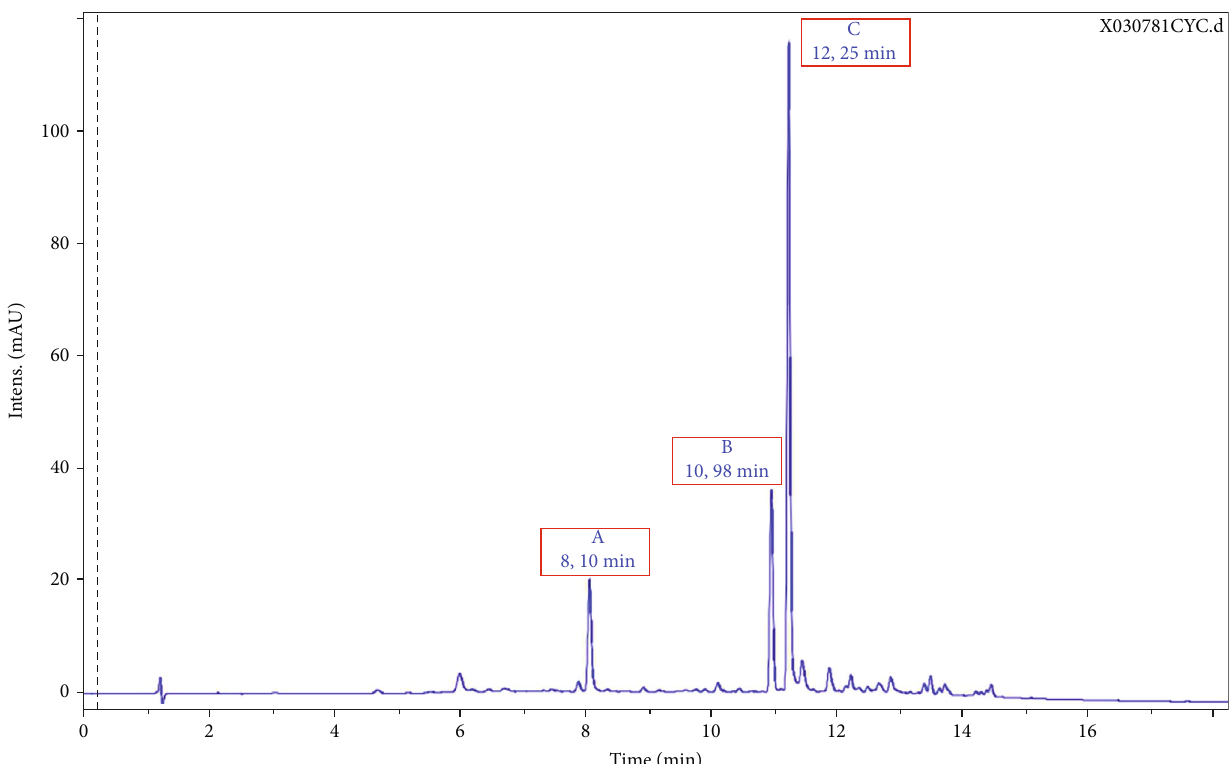
Figure 2: Chromatographic pro fi le of a typical corn fl ower extract obtained from raw material after cold pressure in UV at 313nm (concentration 0.5mg/mL).